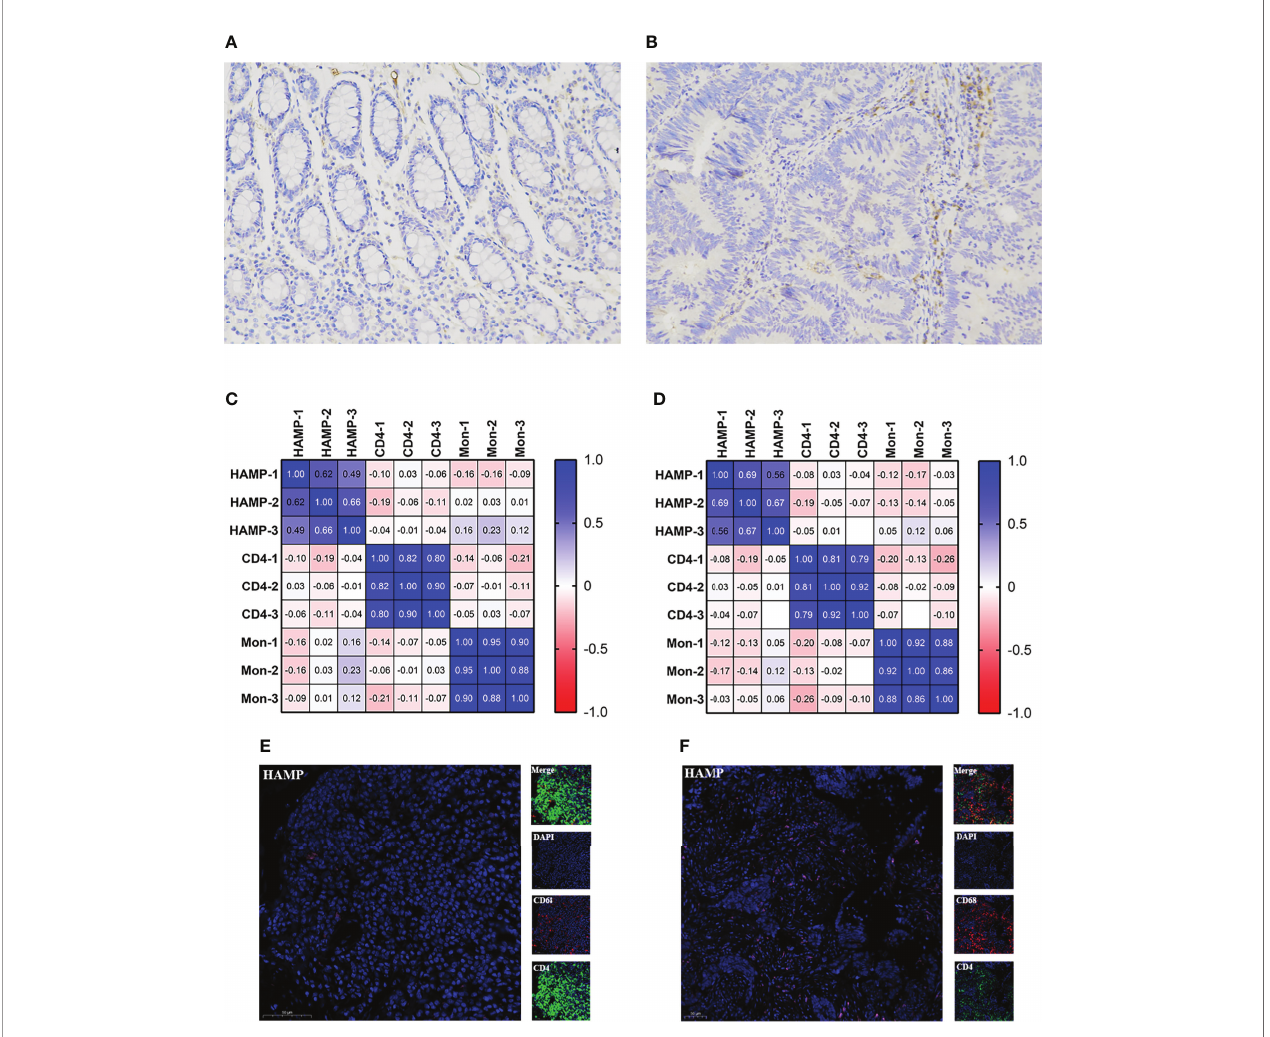
FIGURE 6 | Relationship between HAMP and CD4+ T cells and M0 macrophages. (A, B) Immunohistochemistry of HAMP in clinical samples. The left fi gure is the control sample, and the right fi gure is the tumor sample. (C) Relationship of HAMP CD4+ T cells and M0 macrophages with positive cells. (D) Relationship of the H score of HAMP CD4+ T cells and M0 macrophages. (E) Immuno fl uorescence staining for the expression of CD4+ T cells (green), M0 macrophages (red) and HAMPs (pink) in control tissue. (F) Immuno fl uorescence staining of CD4+ T cells, M0 macrophages and HAMPs in tumor tissue. Scale bars=50 m m. CD4 represents CD4+ T cells, and Mon represents M0